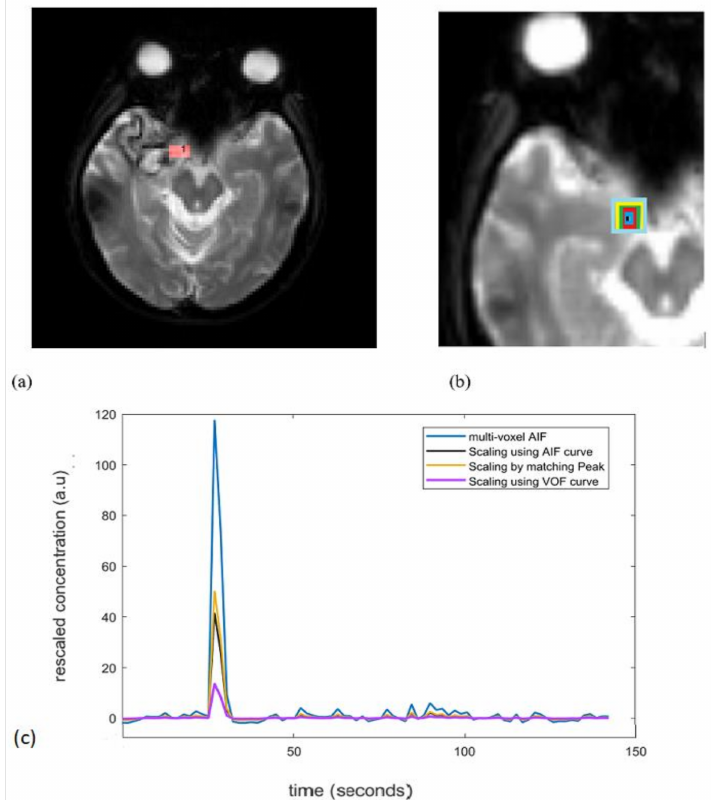
Figure 2. ( a ) Red colored square represents ICA used for reference AIF determination. ( b ) Increased size of the AIF, i.e., AIF concentrations were measured from 3, 5, 7, 9, and 11 voxels centered around the reference ICA voxel shown by black, blue, red, green, yellow, light blue colored squares, respectively. ( c ) An example of non-corrected AIFs (3 voxel AIF; blue curve) and corrected AIFs by all 3 scaling approaches. For a single subject, the unscaled AIF was derived from a 3-voxel-wide region to include the effect of the PVE. ICA: internal carotid artery; PVE: partial volume